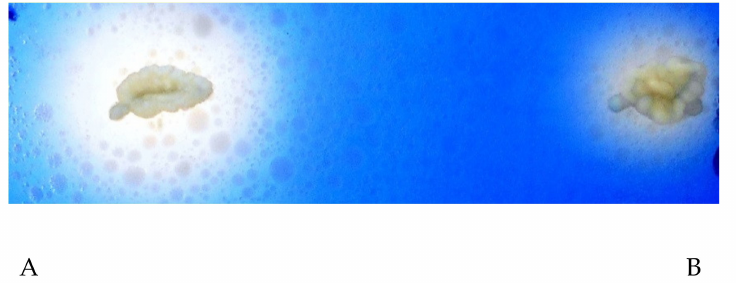
Figure 1. Lipase activity on spirit blue agar medium of Y. lipolytica MIUG D5 ( A ) and Y. lipolytica ATCC 18942 ( B ) strains.